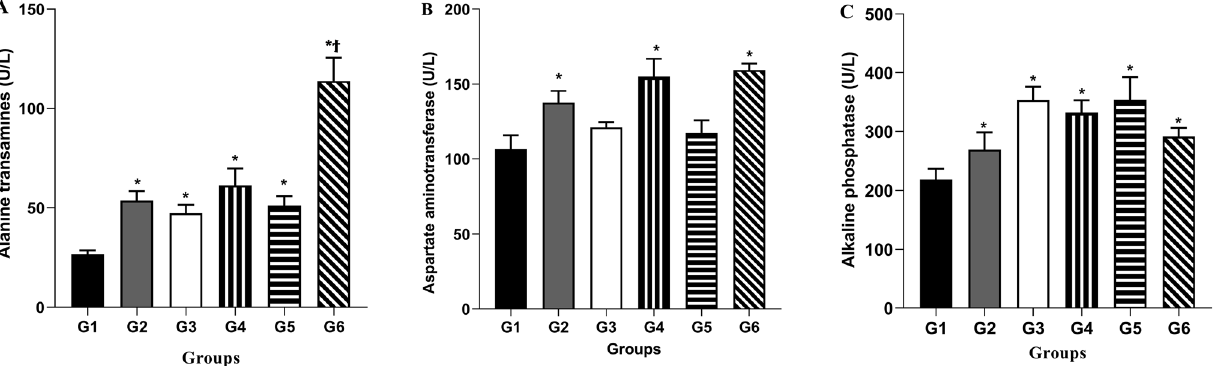
Group 4 (G4), rats were fed HCFD and treated with 10 mg/kg b.w. of BMME; Group 5 (G5), rats were fed HCFD and treated with 30 mg/ kg b.w. of BMME; Group 6 (G6), rats were fed HCFD and treated with 100 mg/kg b.w. of BMME. Data are expressed as means ± S.E.M. and are analyzed by one-way ANOVA followed by Fisher’s LSD test. *Sig- nificant when compared to the normal control group (G1); ϯ signifi- cant when compared to the negative control group